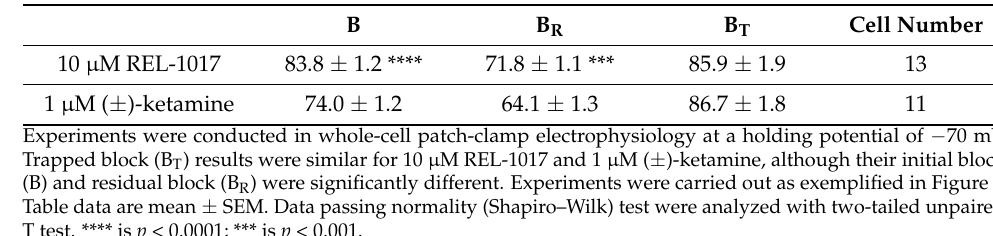
Figure 6. Trapping experiments were conducted in whole-cell patch-clamp electrophysiology at -70 mV holding potential. Trapping experiments were designed to measure trapped block (B T ) of 10 µM REL-1017 or 1 µM (±)-ketamine that is % ratio between residual block (B R ) after extensive (85 s) cell wash with glycine alone and initial test item block (B). Test item application protocol diagram (top) and sample traces (bottom) of trapping experiments with 10 µM REL-1017-treated cell (left) or 1 µM (±)-ketamine-treated cell (right) are shown. I 1st and I 2nd were the peak currents measured within 1 s after onset of the first and second 10 µM/10µM L-glutamate/glycine addition, respectively. Results from trapping experiments are reported in Table 6. s is seconds. Table 6. Trapping parameters.